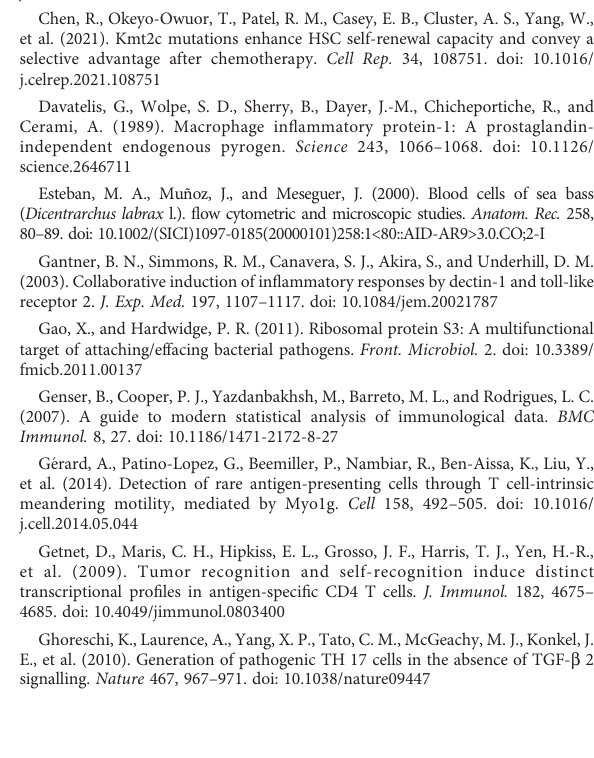
SUPPLEMENTARY TABLE 2 List of enriched pfam of upregulated genes in the peripheral blood